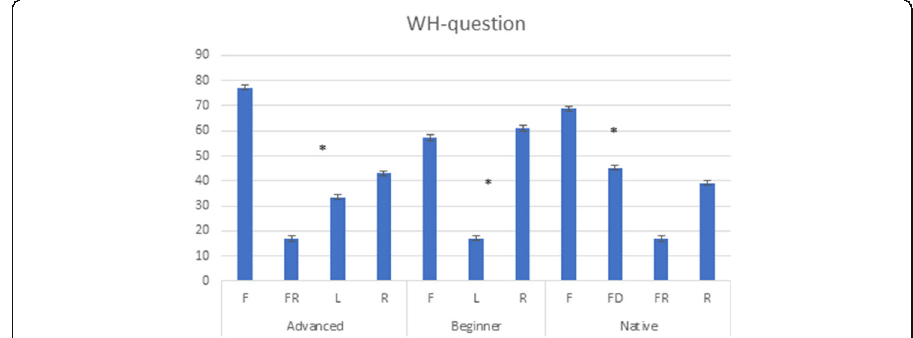
Fig. 5 Mean proportion of final tunes of Wh- questions by speaker groups. Y-axis: mean percentage. The symbol * means significant at p <